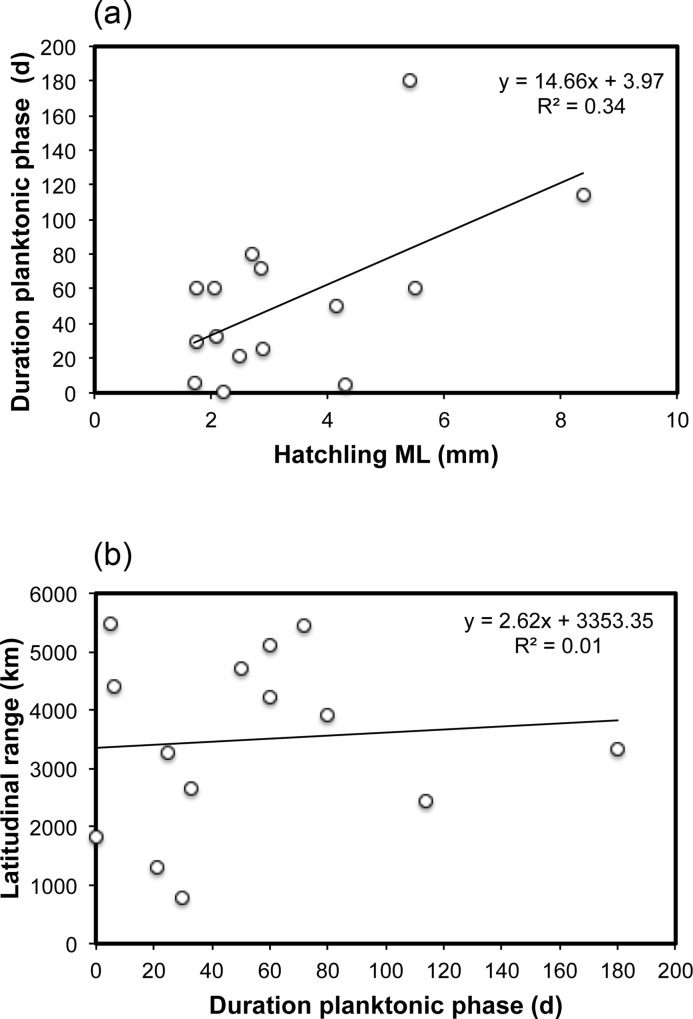
Relationships between (a) hatchling size in mantle length (ML) and duration of the planktonic phase for 15 cephalopod species; and (b) duration of planktonic phase versus latitudinal distribution range for 14 cephalopod species. See Table 2 for details.